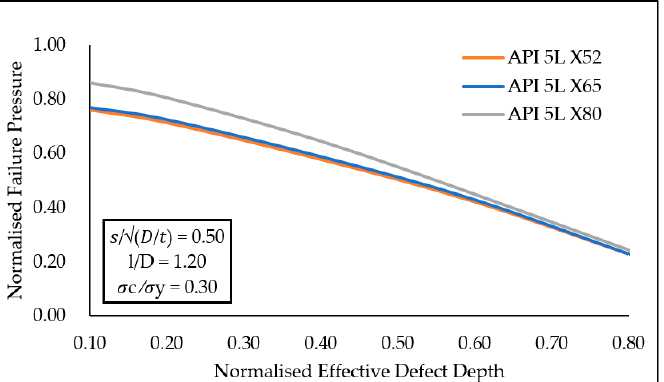
Figure 9. Failure pressure predictions for API 5L X52, X65, and X80 pipe for multiple normalised defect spacings.